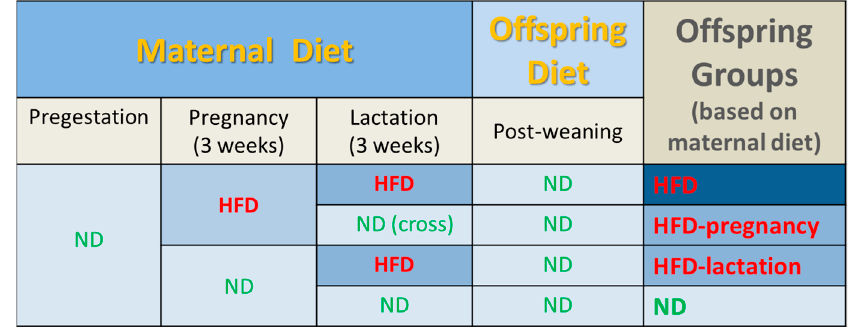
Figure 1. Experimental groups and feeding protocols. Dams were fed either standard rodent chow (normal diet, ND) or high fat diet (HFD) ad libitum during pregnancy from embryonic day 1; n = 6 / group. At the time of birth, half of the mothers from both groups were switched to the opposite respective diet, generating 4 groups of o ff spring based on gestational (intrauterine) and lactational (early postnatal) maternal HFD or ND exposure as follows: (1) HFD during gestation and lactation (HFD); (2) HFD during pregnancy and ND during lactation (HFD-pregnancy), with the o ff spring cross-fostered at birth to ND dams never previously exposed to HFD; (3) ND during pregnancy and HFD during lactation (HFD-lactation); and (4) ND during both gestation and lactation (ND). Following weaning, all o ff spring were maintained exclusively on ND throughout the course of experiment. Taste testing commenced on postnatal day 70. Abbreviations: HFD, high fat diet; ND, normal